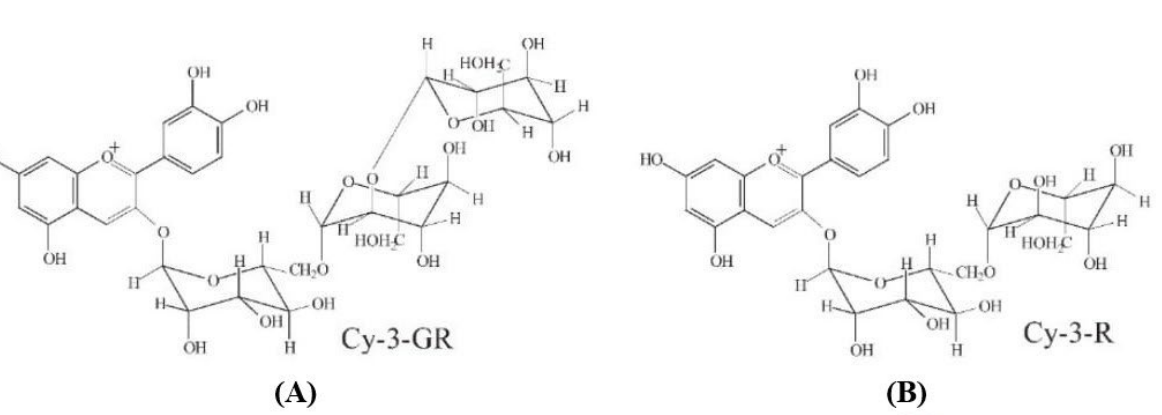
Figure 15. Structures of anthocyanins: ( A )—cyanidin-3-glucosylrutinsoid (Cy-3-GR) and ( B )—cya- nidin-3-rutinoside (Cy-3-R), characteristic of cherry fruits.